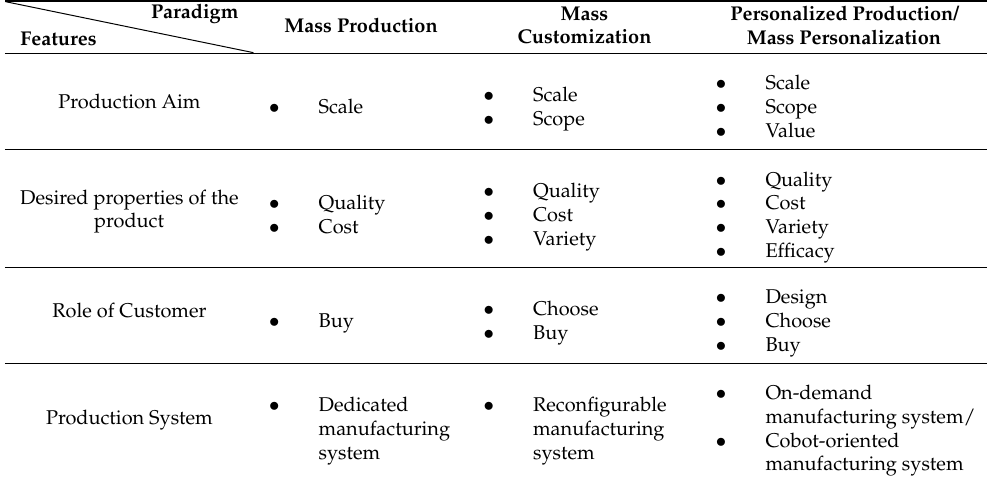
Table 2. Key differences between production paradigms (Source: based on [43]).